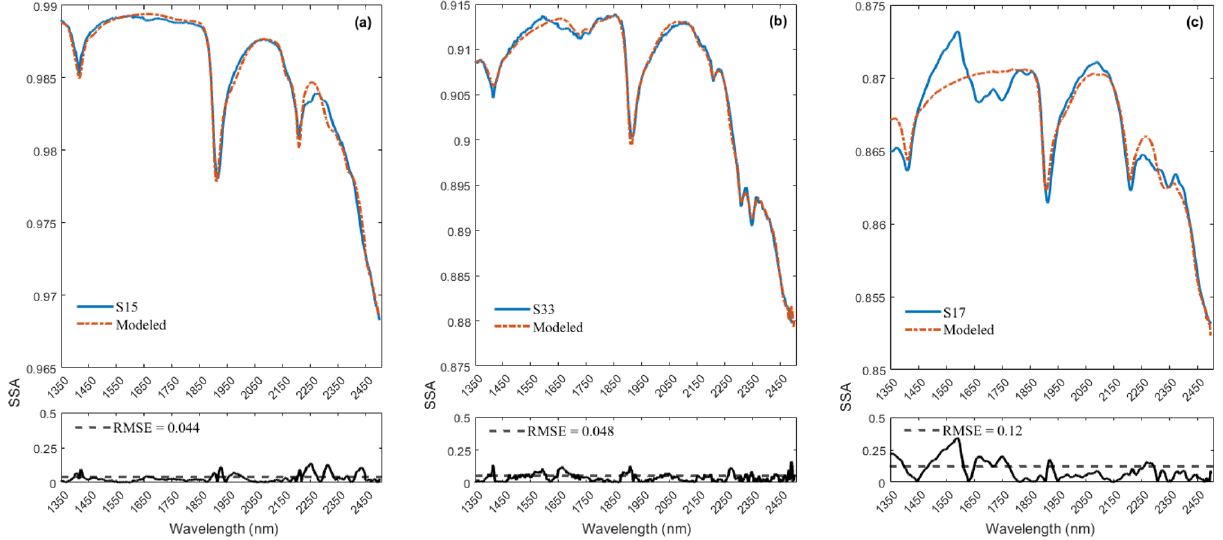
Figure 6. Panels (a) – (c) display the model fit for the representative samples S15, S33, and S17. Measured spectra are shown with solid blue lines and modeled with dash-dot red lines. The smaller plots on the bottom show the root mean square error (RMSE) as a function of wavelength and the total RMSE. The fit uses SSA derived from library endmember reflectance spectra. Out of 37 modeled spectra, S15 (a) and S33 (b) represent relatively good fits and low RMSE; however, S17 (c) shows misfits and a relatively high RMSE. Materials contributing to the misfits are discussed in the text.